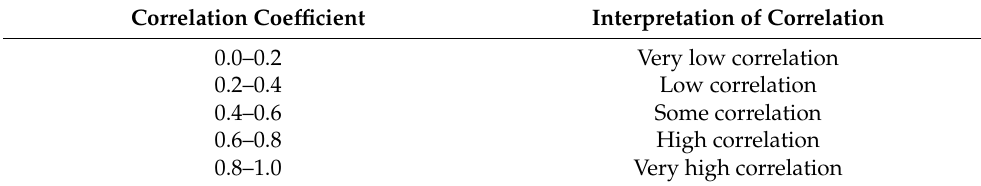
Table 8. Correlation coefficient